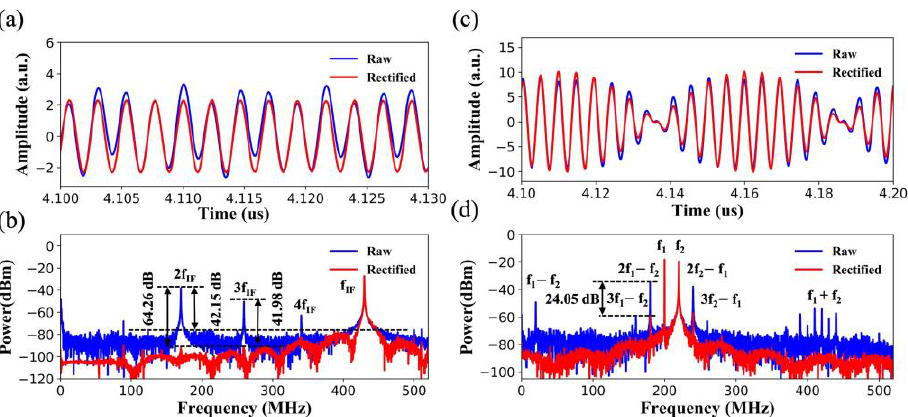
Figure 5. Examples of spurious elimination for a single-tone sinusoidal signal with the frequency of 0.60 GHz, which was down-converted to the frequency of 430 MHz. ( a ) Comparison of the time-domain waveform before and after rectification by Resnet model; ( b ) Elimination of spurious spectral components of the down-converted second harmonic (170 MHz), third harmonic (260 MHz), and fourth harmonic (340 MHz). Examples of spurious suppression testing by dual-tone signals with frequencies of 200 MHz and 220 MHz; ( c ) Comparison of the time-domain waveform before and after rectification by Resnet model; ( d ) Result-contrast effects of the suppression of the third intermodulation products (180 MHz and 240 MHz), the sum frequency (420 MHz), and other cross-modulation distortions in the frequency domain.